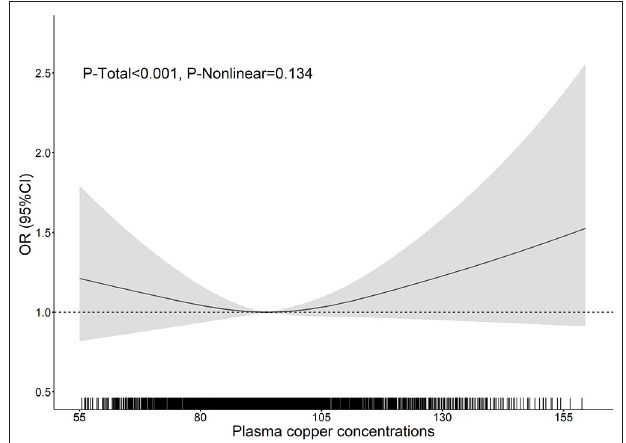
FIGURE 2 | The association between plasma copper concentrations and prevalence of diabetes in 2,579 Chinese adults with hypertension. The association between plasma copper concentrations and the prevalence of diabetes was depicted using restricted cubic spline with three knots (10th, 50th and 90th). Black solid lines were estimated OR of diabetes risk associated with plasma copper concentrations. Gray shade area showed corresponding 95% CI. Dotted lines located at OR as 1 indicating no association. The rugs showed fraction of participants with different plasma copper concentrations ranging from 55 to 160 µ g/dL. The OR of diabetes prevalence associated with plasma copper concentrations was adjusted for age, sex, current smoking, current alcohol drinking, BMI, family history of diabetes, SBP, DBP, tHcy, TC and TG. BMI, body mass index; DBP, diastolic blood pressure; SBP, systolic blood pressure; TC, total cholesterol; TG, triglycerides; tHcy, total